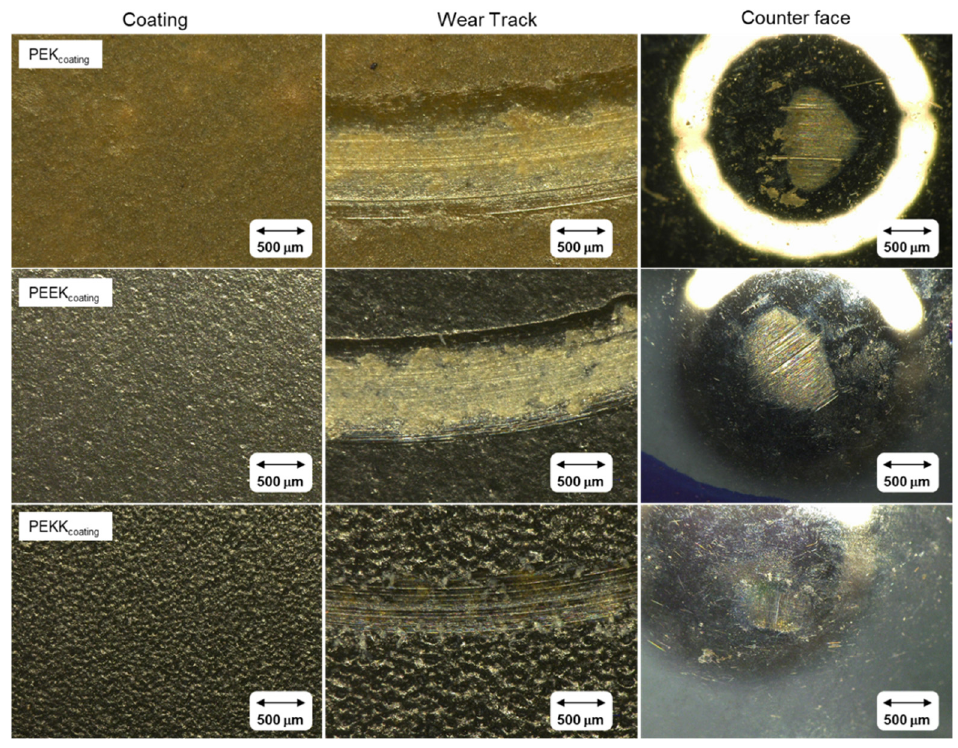
Figure 16. Optical microscope images of each coating and counter face tested: not-worn coating, wear track and counterface.